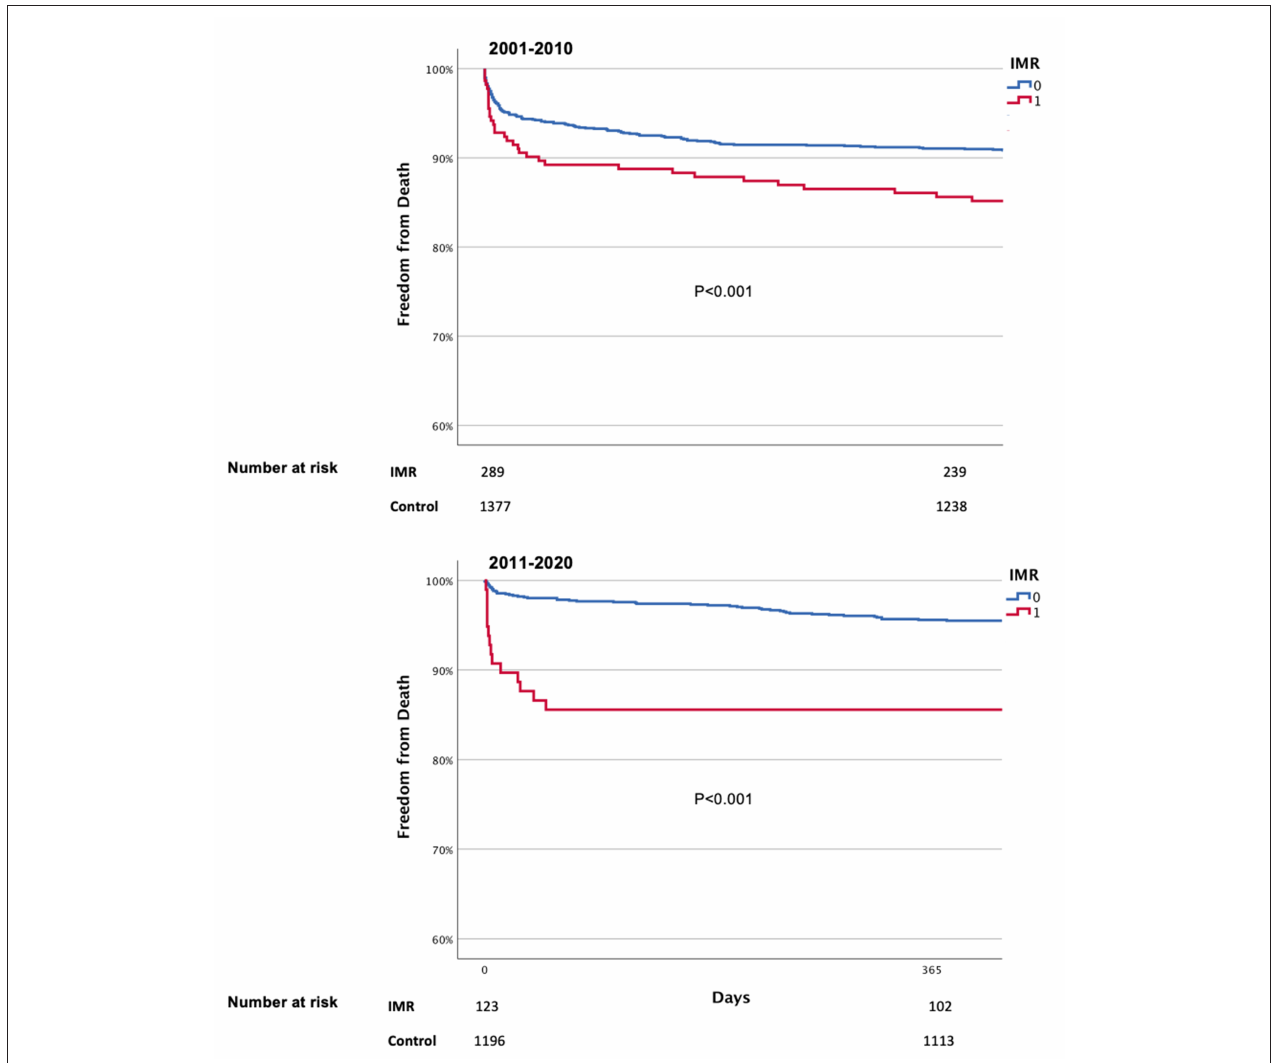
FIGURE 5 | Kaplan Meier curves of survival by